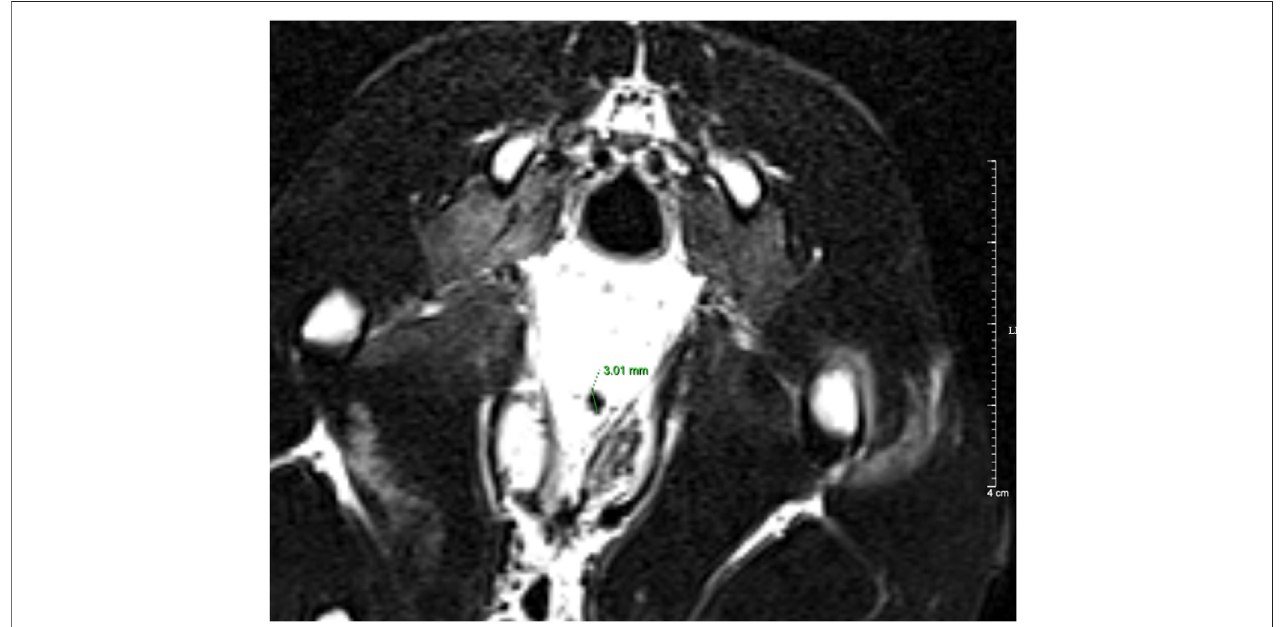
FIGURE 6 | T 2 -weighted MRI image of a resolved VUR rabbit. The diameter of the bulking agent shown in the image was 3.01 mm.